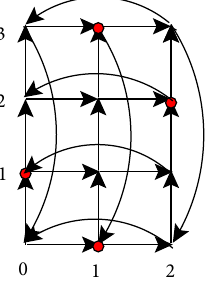
󳨀→ (cid:31) 󳨀→ 𝐶 of 𝐷 = 𝐶 𝐷 3 4